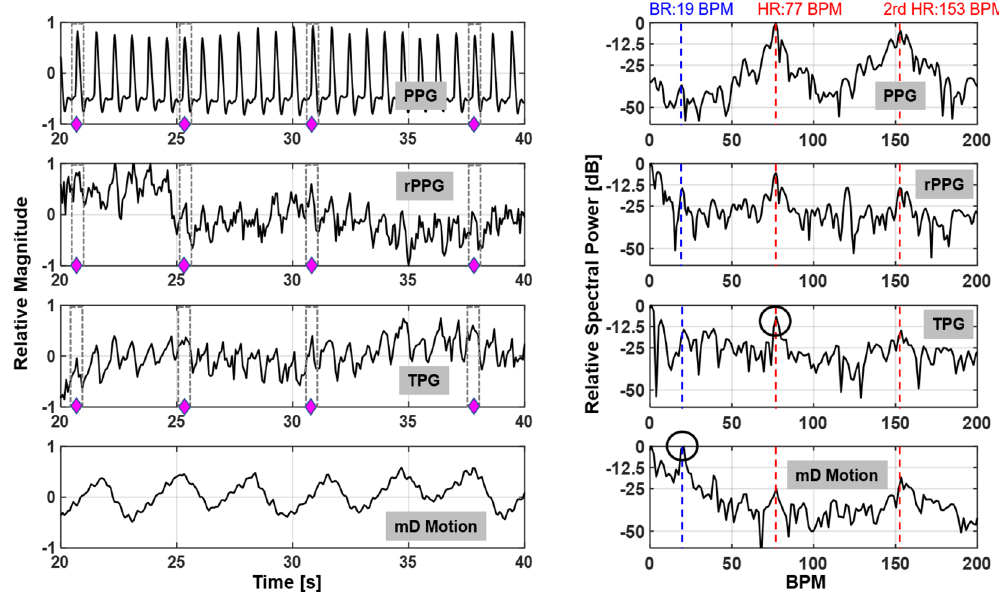
Figure 6. Waveform comparison from different measurement sensor outputs and their associated spectra. The left column shows temporal waveform of PPG, rPPG, TPG and mD phase; the right column their spectra at the frequency of interest. The measurement are synchronized as indicated by the diamond markers. Major spectral components related to pulse and breathing are labeled by blue and red vertical lines. The higher-order harmonic of heartbeat is highlighted for cross-validation of the fundamental heartbeat spectral